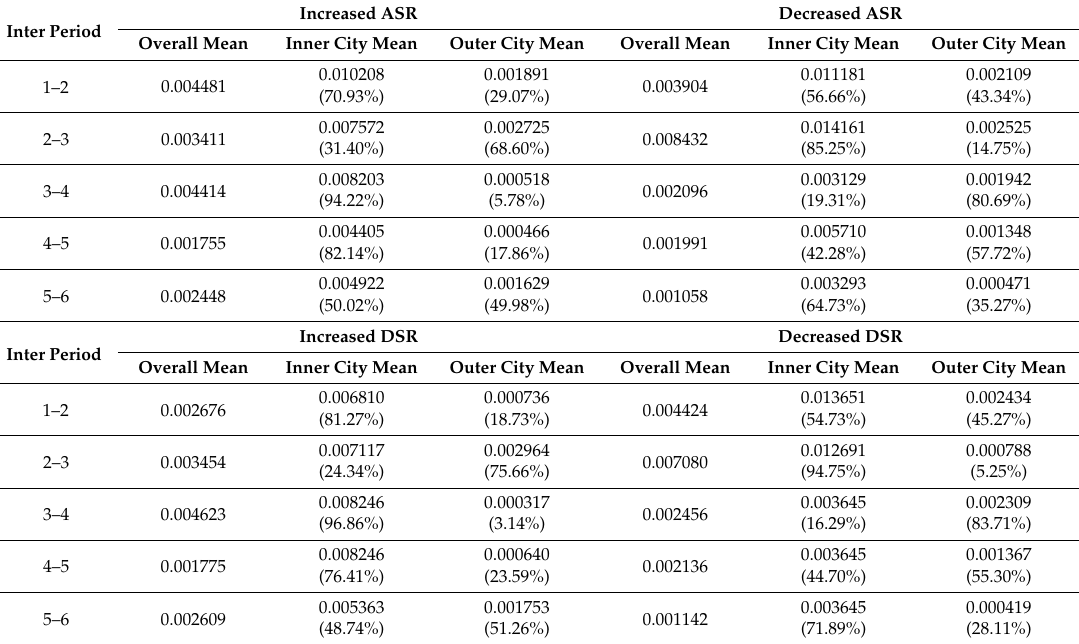
Table 7. The overall mean, the inner city mean, and the outer city mean of increased and decreased service rate on weekdays between each pair of neighboring